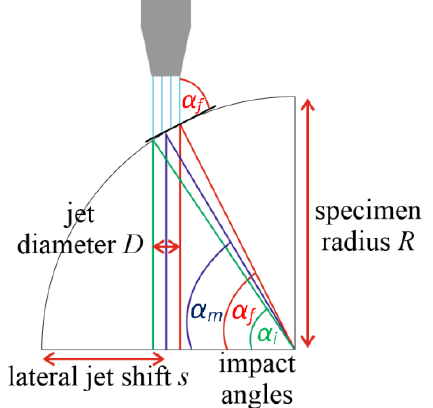
Figure 3. Relationship between lateral jet shift and impact angle.